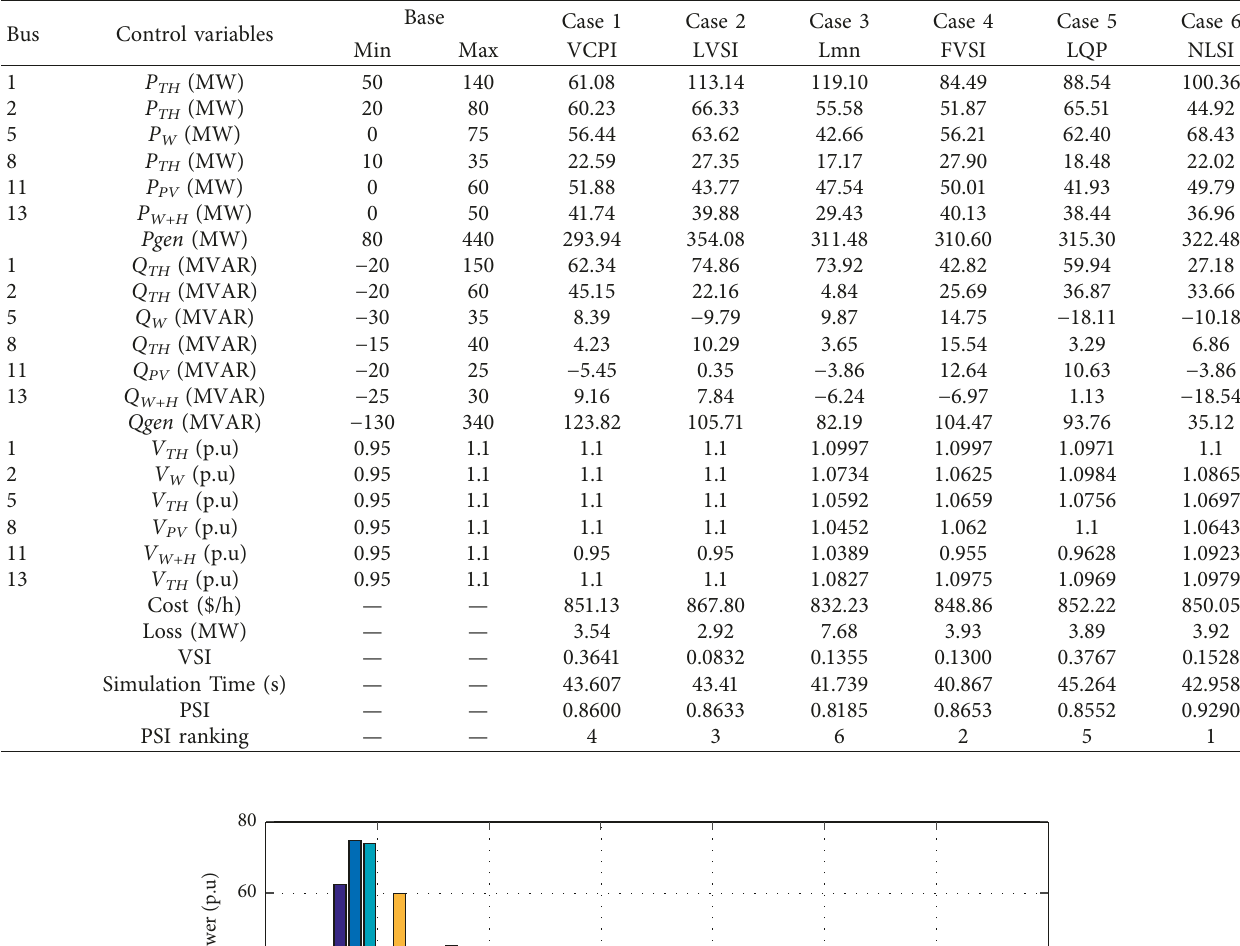
Table 8: Best compromise solutions from the different case studies in SC-2.